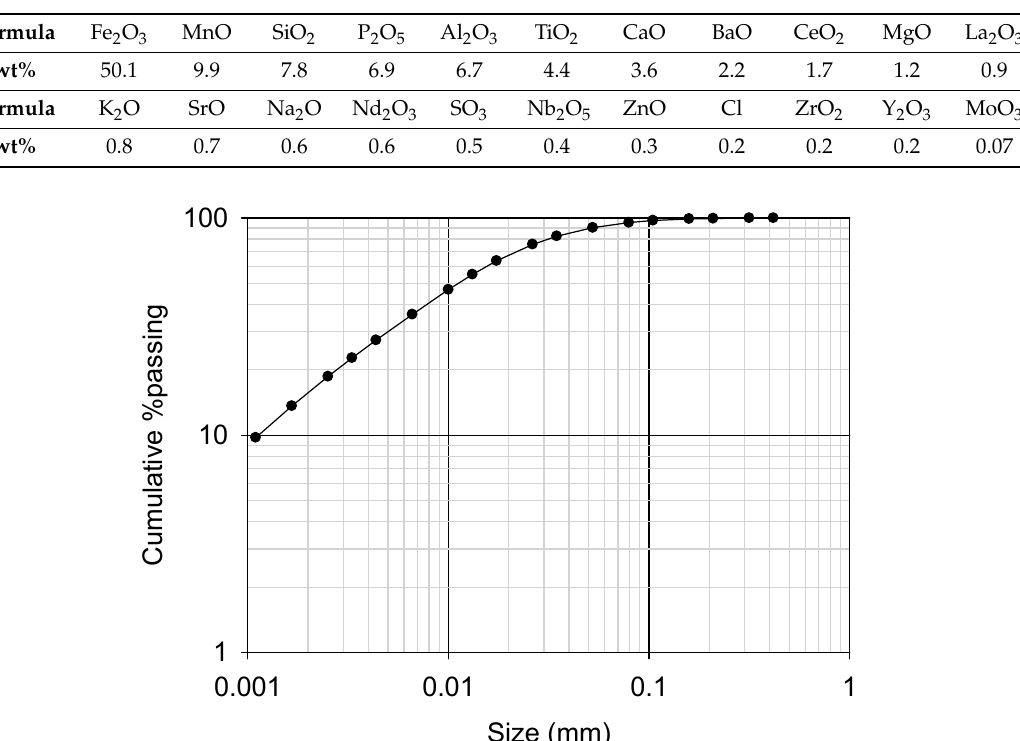
Figure 4. Cumulative particle size distribution of the ground REE ore (P 80 of 30 µm).